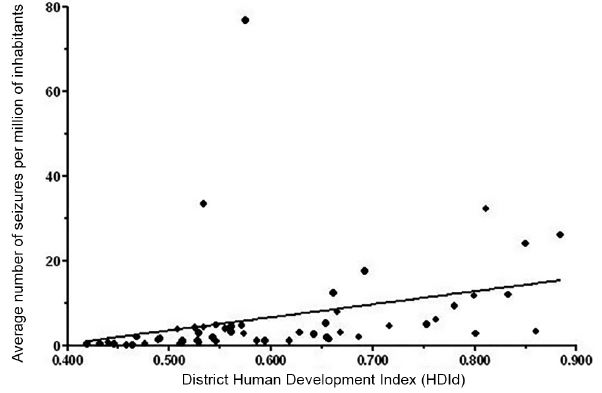
FIGURE 2 - Spearman correlation between average number of seizures per million of inhabitants and District Human Development Index (HDId) (rho = 0.7013; p<0.01;